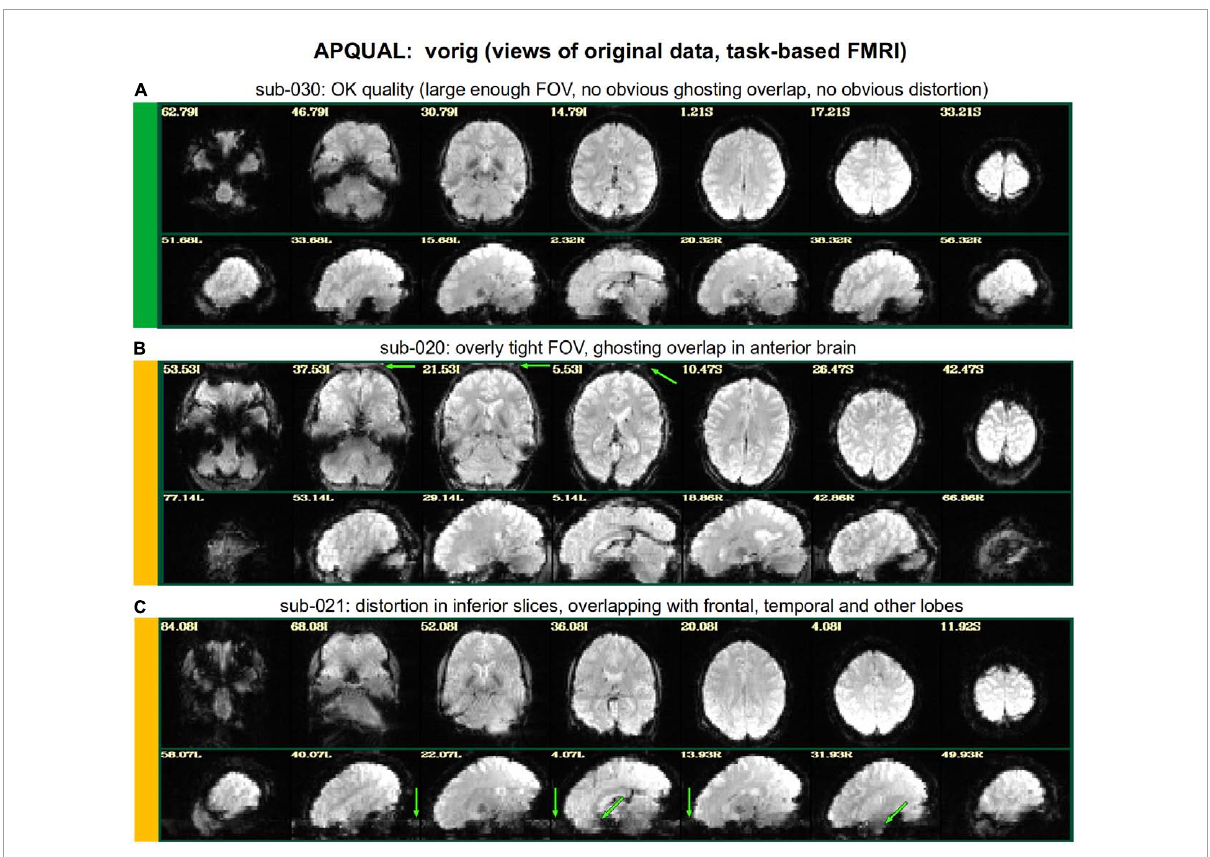
FIGURE11 APQUAL examples for the task-based FMRI group from the “vorig” QC block: Visualizations of the original datasets (here, just the EPIs). See Table 5 for brief, overall evaluations for each subject, and the Supplementary Table 1 for detailed QC comments. (A) The EPI does not appear to have any major artifact, ghosting or distortion, and tissue contrast is reasonable. (B) The FOV of this volume is overly tight for this subject, so that there is ghosting of the posterior brain and skull which overlaps the anterior portion. (C) The inferior slices show a ghosting or phase distortion artifact—part of the frontal and temporal lobe regions are notably